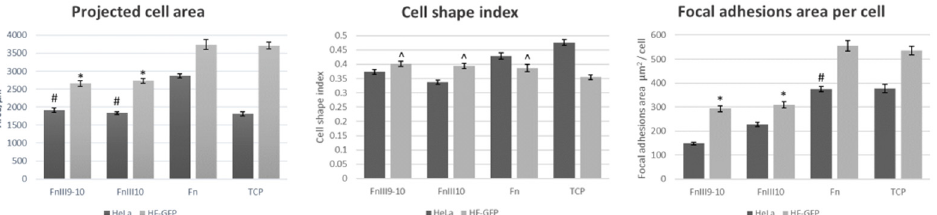
Figure 5. Statistical analysis of single GFP-transfected human fibroblast (HF-GFP) and HeLa cells adherent onto FnIII9-10, FnIII10 and Fn-modified biochip surfaces and tissue culture plate (TCP). The cells were immunostained for vinculin. The focal adhesion area per cell was calculated according to the number of vinculin points. The data are presented as mean ± standard error of between 83 and 335 cells from 4–7 samples of each type. * marks a statistically significant difference compared to the samples of the same cell type grown on Fn and TCP, ∧ —compared to the samples on TCP, #—compared to Fn (projected cell area), #—compared to Fn domains (focal adhesions area per cell). ANOVA with post hoc LSD test, p < 0.05.